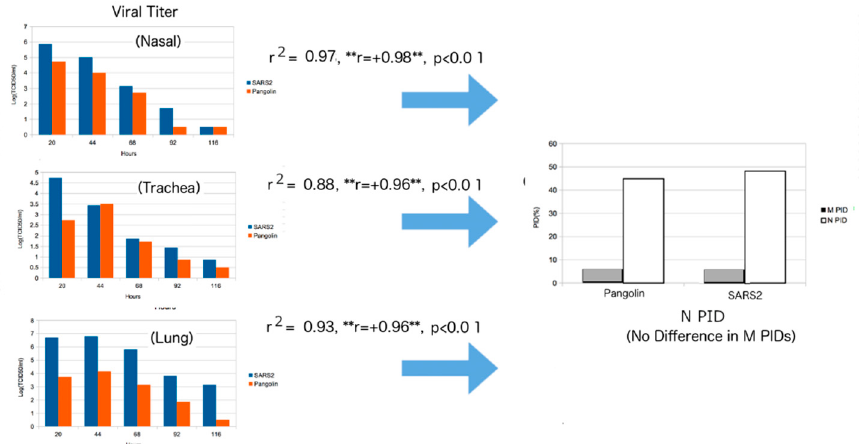
Figure 7. Regression Analysis of Viral Titer of pangolin-CoV/SARS-CoV-2 and PID N and PID M Values. Phylogenetic tree using M protein. The figure is a statistical extension of the data from [44] using disorder information. The regression model used is: VT = A × PID N + B × Time + C, where VT = Viral Titer, A,B = Coefficients, C = Y-Intercept. ** Notice that the correlation(r) has not changed with different samples, unlike the HKU experiment in Figure 6.